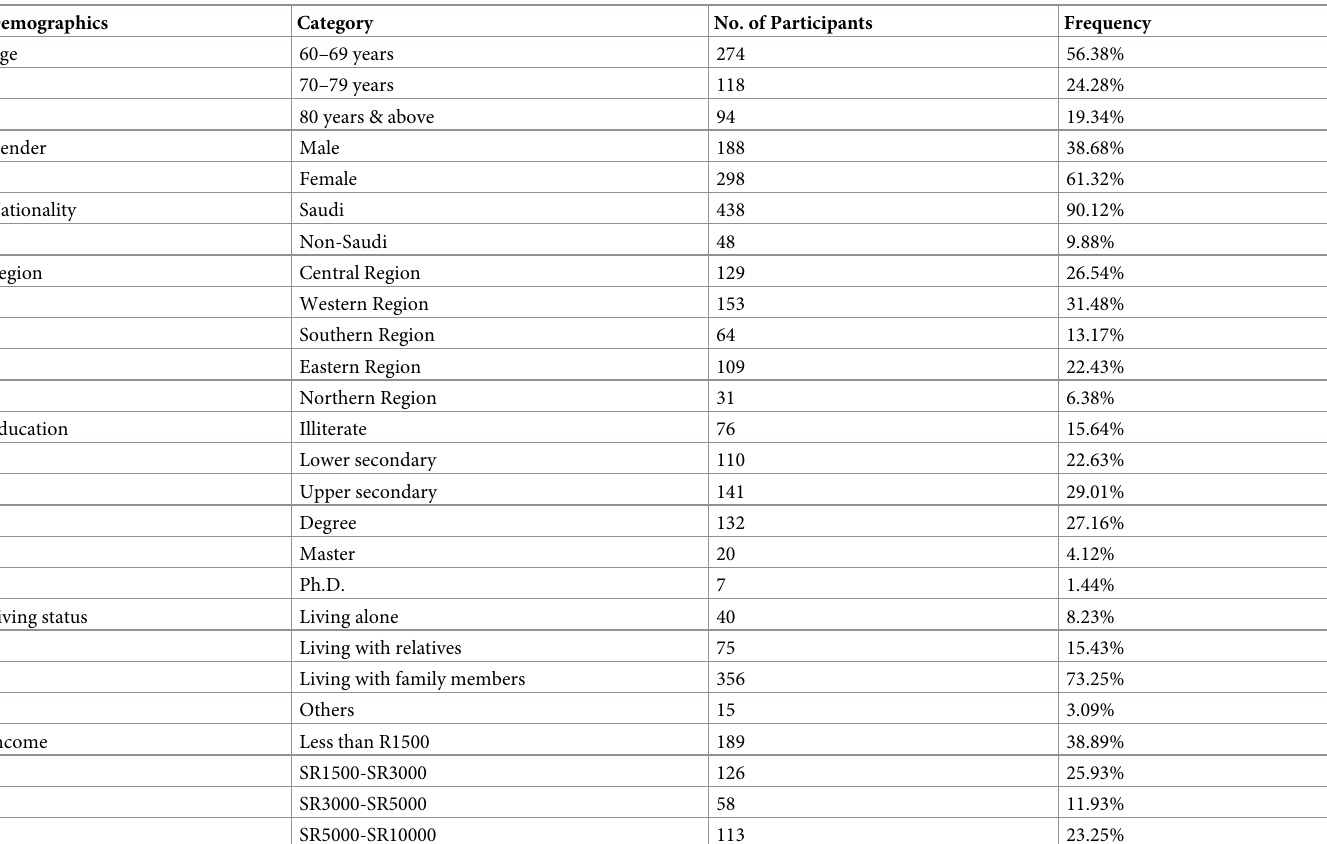
Table 2. Descriptive statistics of demographic characteristics of